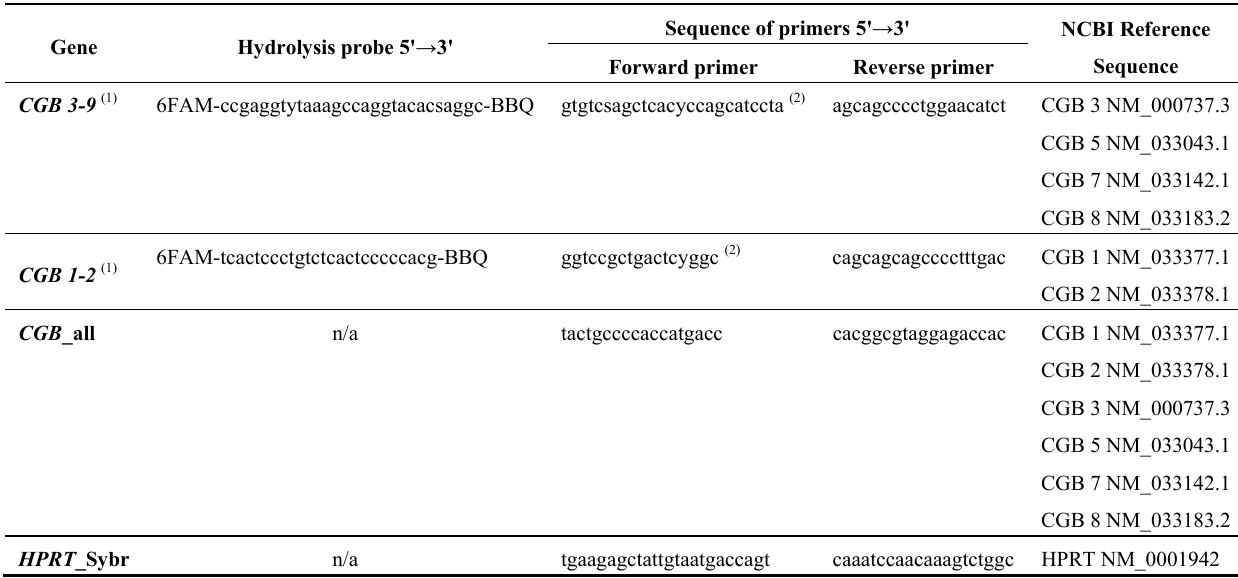
Table 3. Primers and hydrolysis probes used in